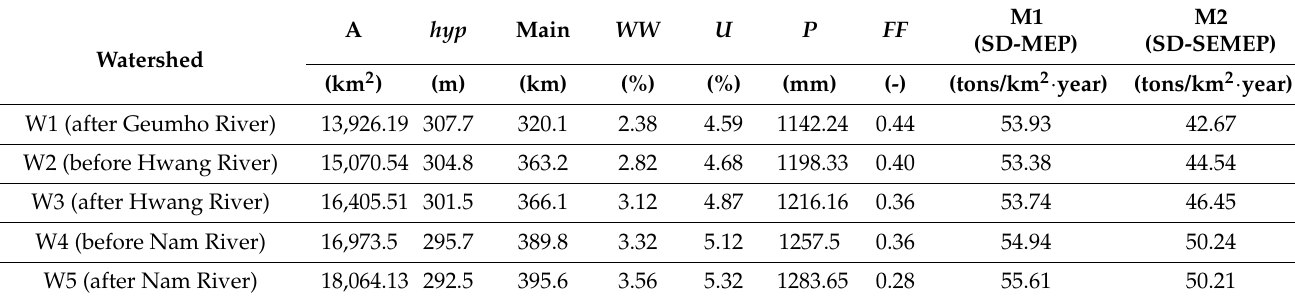
Table 9. Validation result of models M1 and M2.